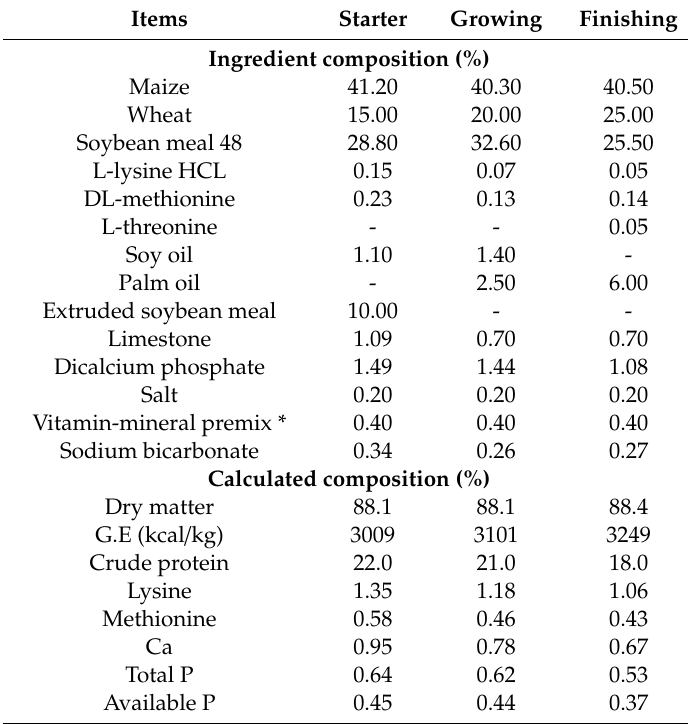
Table 1. Ingredients and nutrient composition (% as fed-basis, unless otherwise indicated) of basal diet.